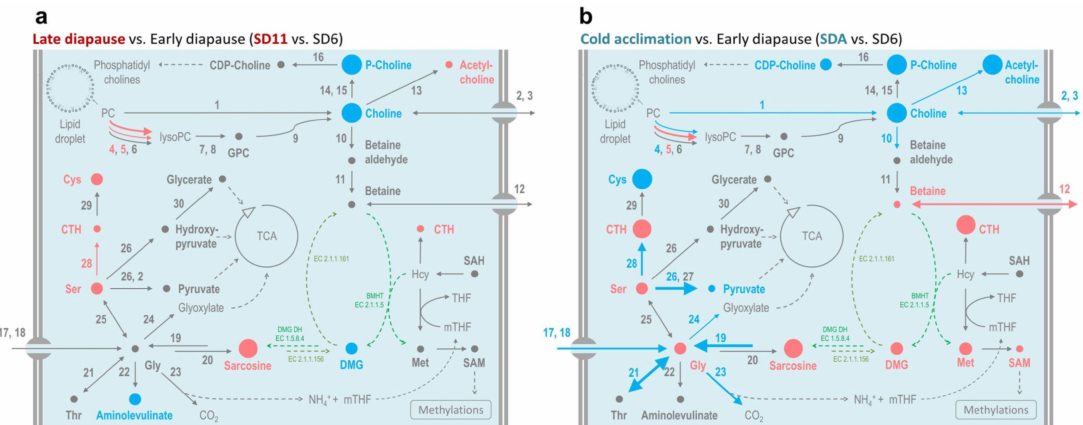
Figure 6. Changes in metabolism of betaine during diapause maintenance and cold acclimation. The maps show log2-fold changes in relative concentrations of metabolites (circles) and gene ex- pressions (arrows) during diapause maintenance ( a ) and gradual cold acclimation ( b ) (see Table S6). Other descriptions are as in Figure 2. TCA, tricarboxylic acid cycle; DMG, dimethylglycine; SAM, S-adenosylmethionine; SAH, S-adenosylhomocysteine; (m)THF, (methyl-) tetrahydrofolate; (lyso)PC, (lyso) phosphatidylcholine; GPC, glycerol 3-phosphocholine; BHMT (EC 2.1.1.5), betaine homocys- teine methyltransferase; DMGDH (EC 1.5.8.4), DMG dehydrogenase; EC 2.1.1.156, sarcosine DMG methyltransferase; EC 2.1.1.161, DMG betaine methyltransferase.